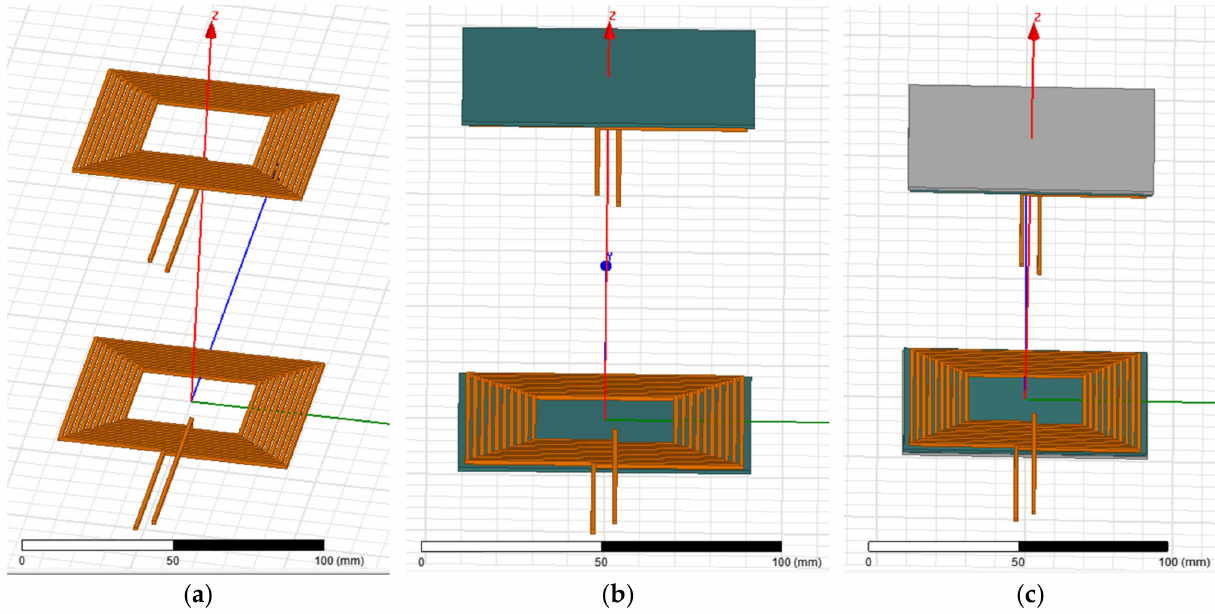
Figure 6. Rectangular coil model for gap = 100 mm: ( a ) coreless model, ( b ) model with ferrite, ( c ) model with ferrite and aluminum.